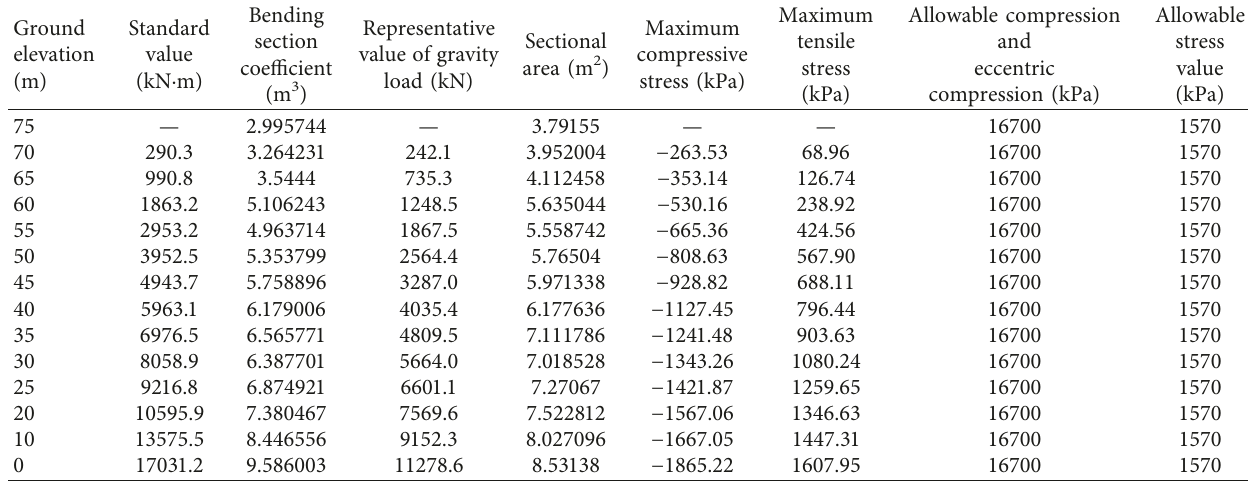
Table 10: Maximum stress values under the action of a rare earthquake.